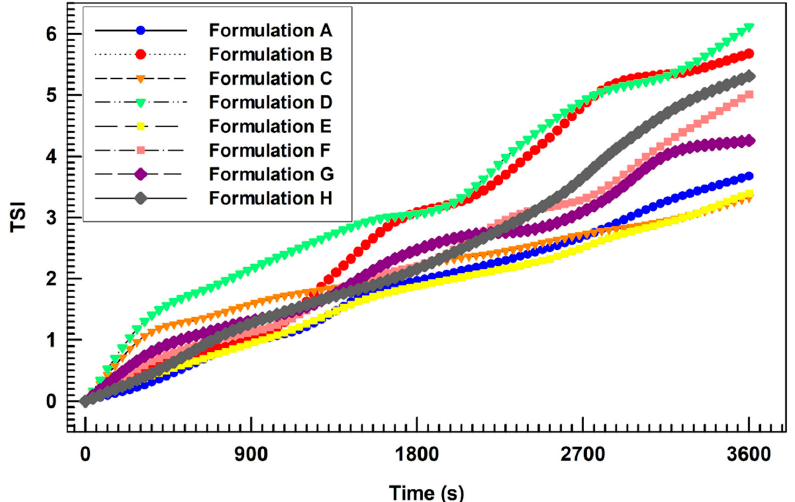
Figure 3. Turbiscan Stability Index (TSI) profiles of all prepared formulations, obtained by using the Turbiscan Lab ® Expert.